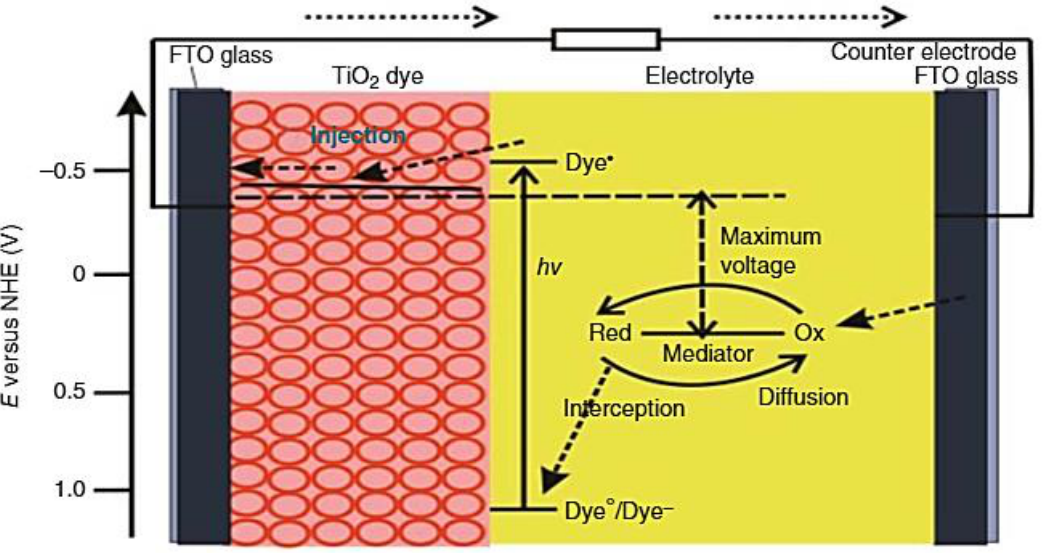
Figure 6. Schematic diagram of the working principle of DSSCs. Reproduced from [108].